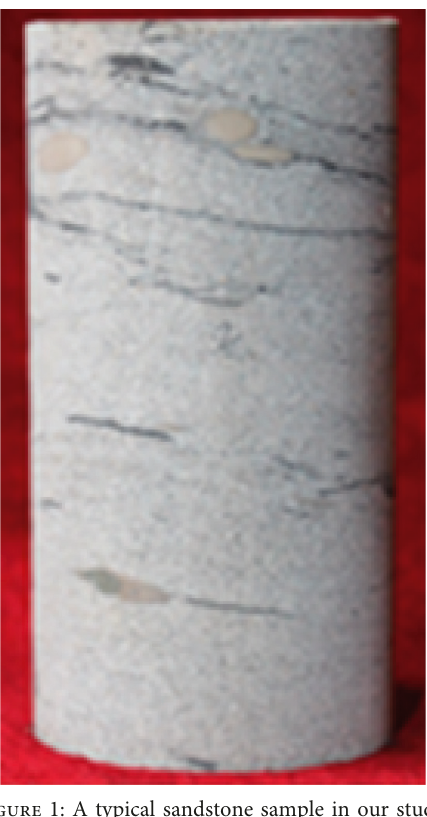
Figure 1: A typical sandstone sample in our study.